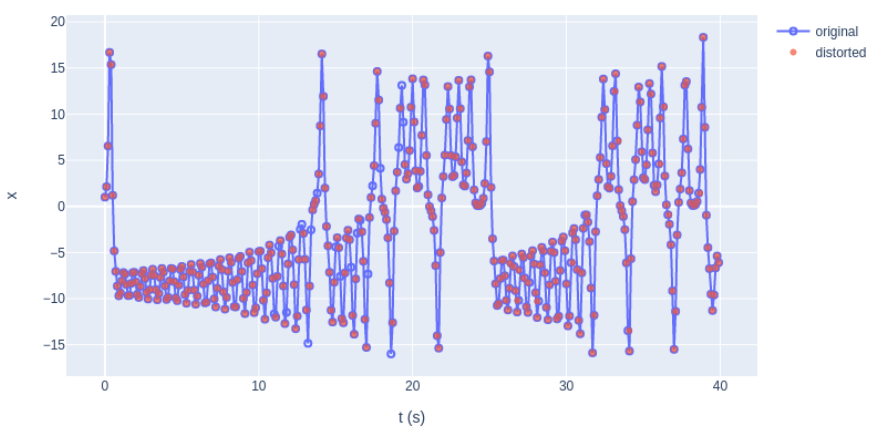
Figure 7. Original vs. distorted Lorenz first dimension.